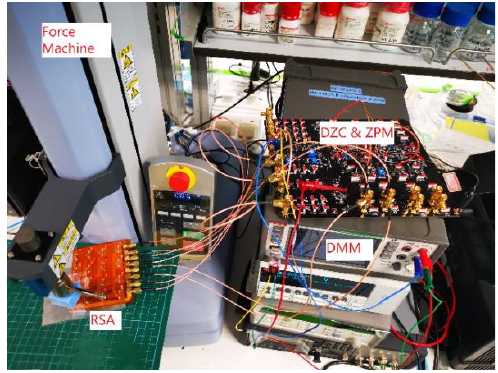
Figure 13. Force sensor test bench.